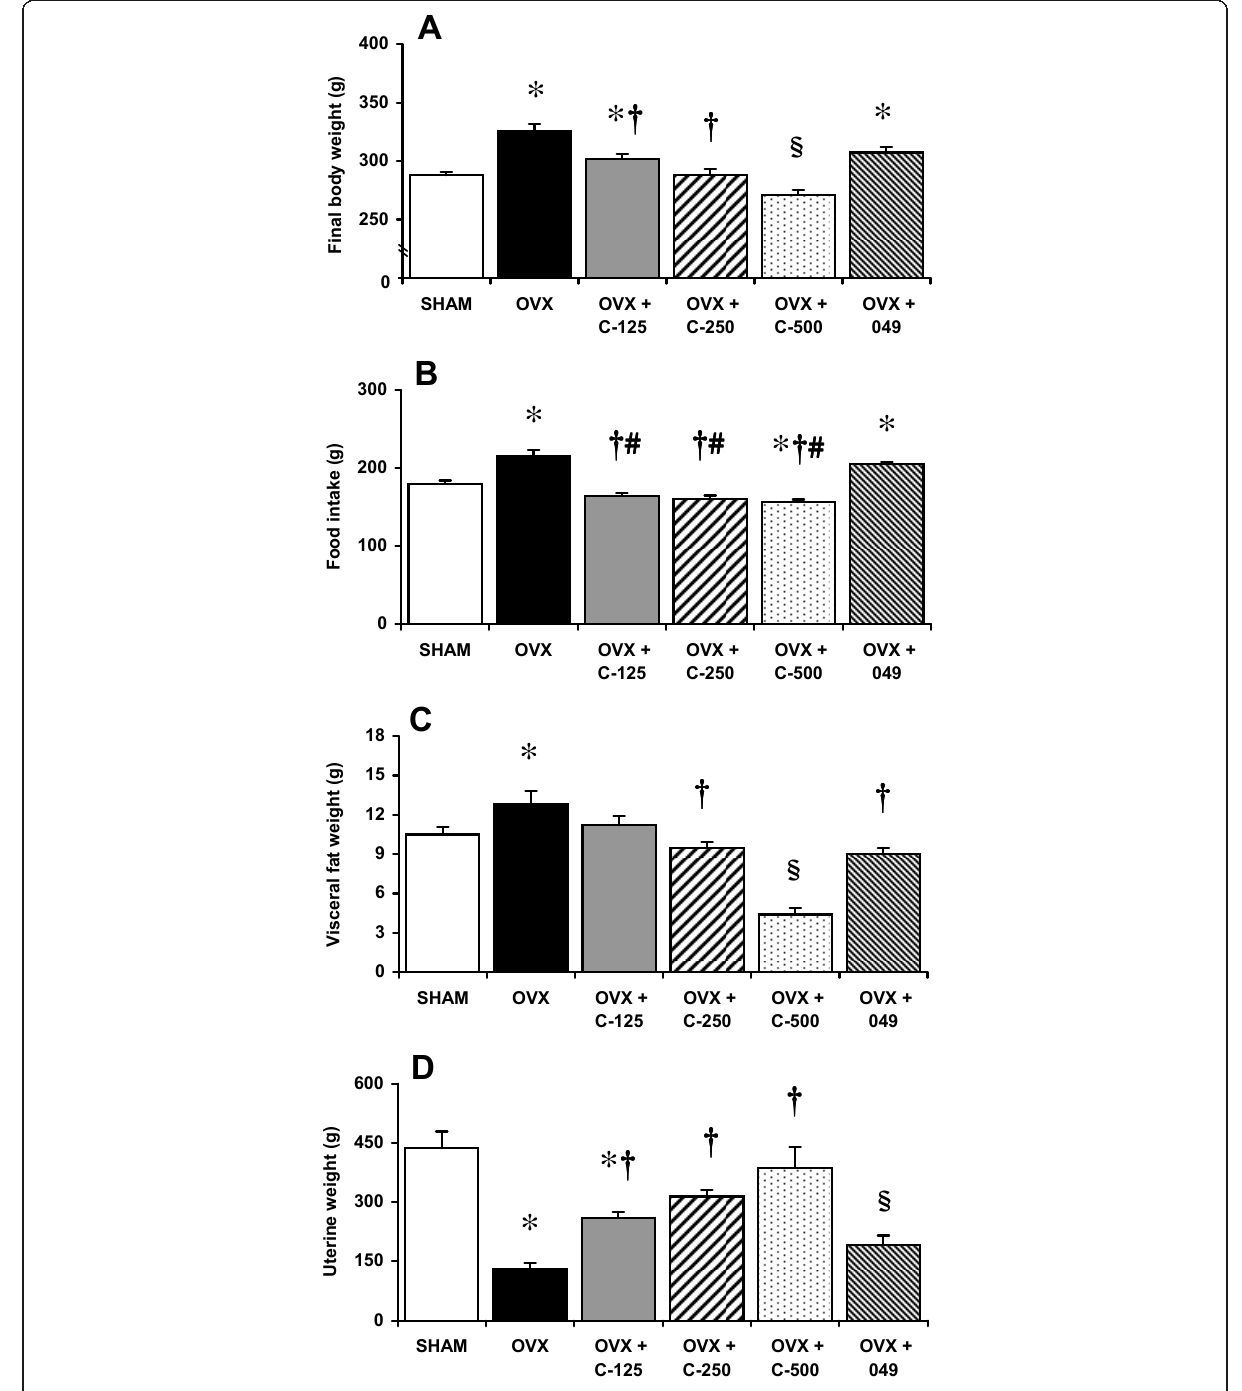
Figure 2 Final body weight, food intake, visceral fat weight and uterine weight of sham operated control (SHAM) and ovariectomized (OVX) rats treated with or without C. comosa hexane extract at 125 mg (OVX + C-125), 250 mg (OVX + C-250), and 500 mg (OVX + C- 500) per kg body weight or 50 mg of compound 049 per kg body weight (OVX + 049) . Final body weight (A); accumulated amount of food intake (B); visceral fat weight (C); uterine weight (D). Values are reported as the mean ± SE for 8 animals/group. * P < 0.05 vs. SHAM group; † P < 0.05 vs. OVX group; # P < 0.05 vs. OVX + 049; § P < 0.05 vs. all other